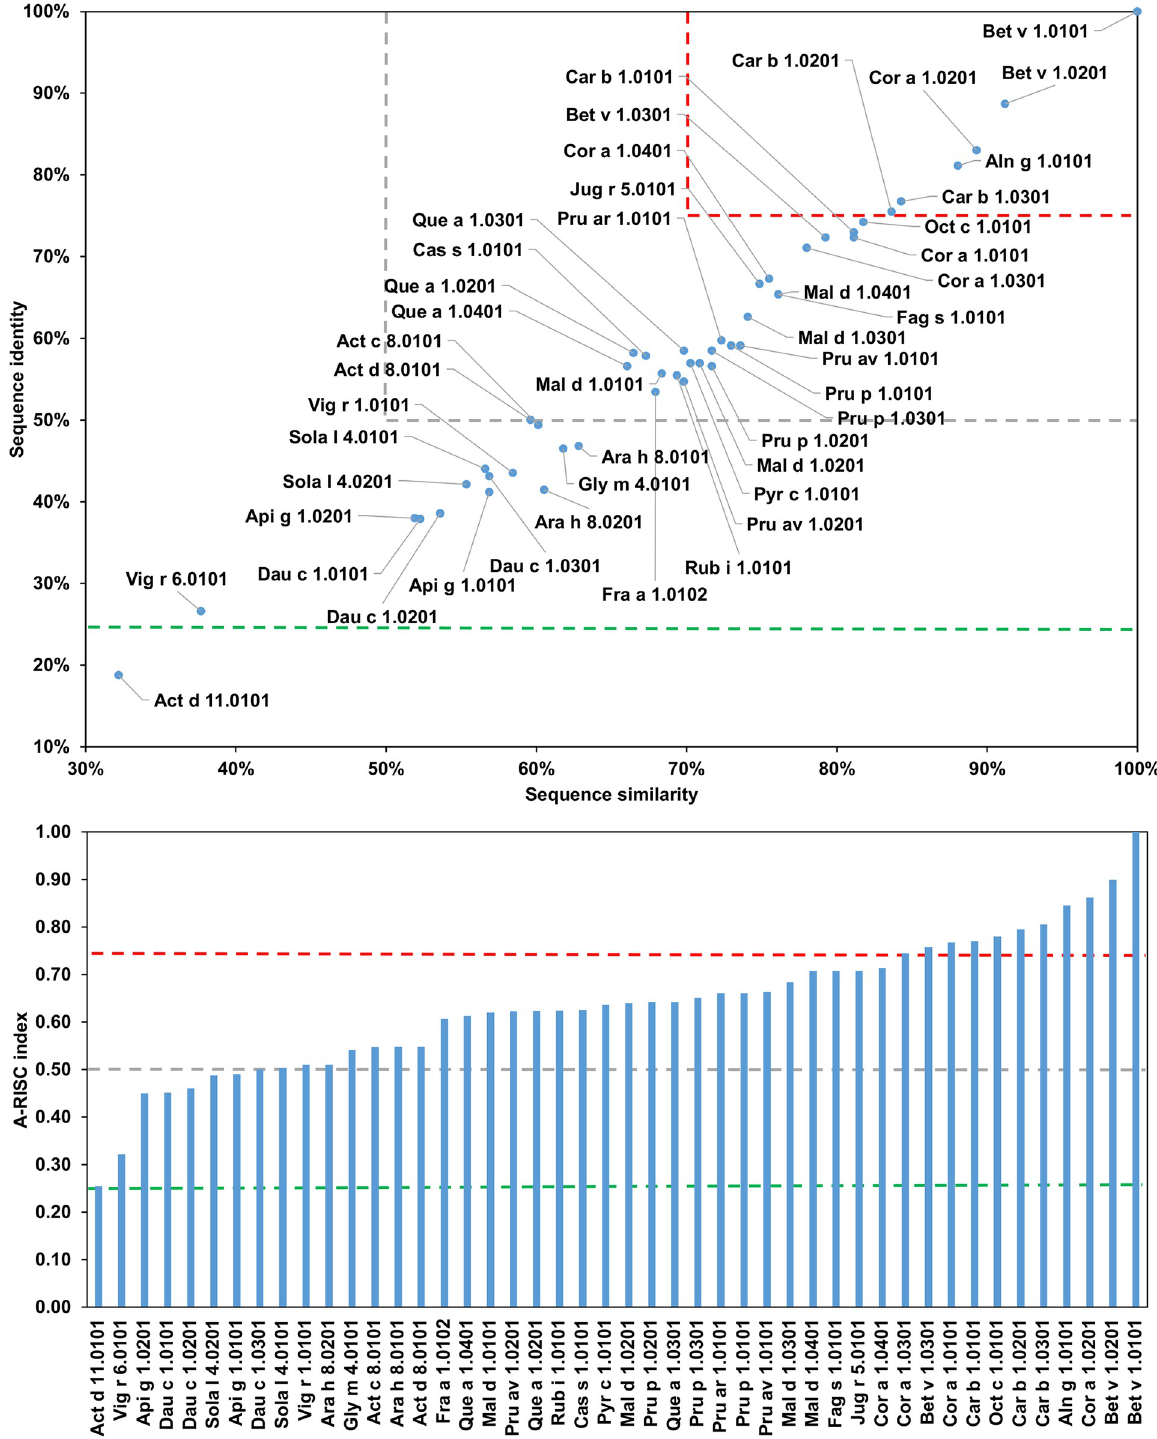
Fig 27. Plots showing relative homology and A-RISC indexes of allergens from PR-10 (Bet v 1-like) family. Comparison of the family members to Bet v 1.0101. Red, gray, and dark green dashed lines indicate respectively 75%, 50% and 25% sequence identity and similarity, or 0.75, 0.50 and 0.25 A-RISC